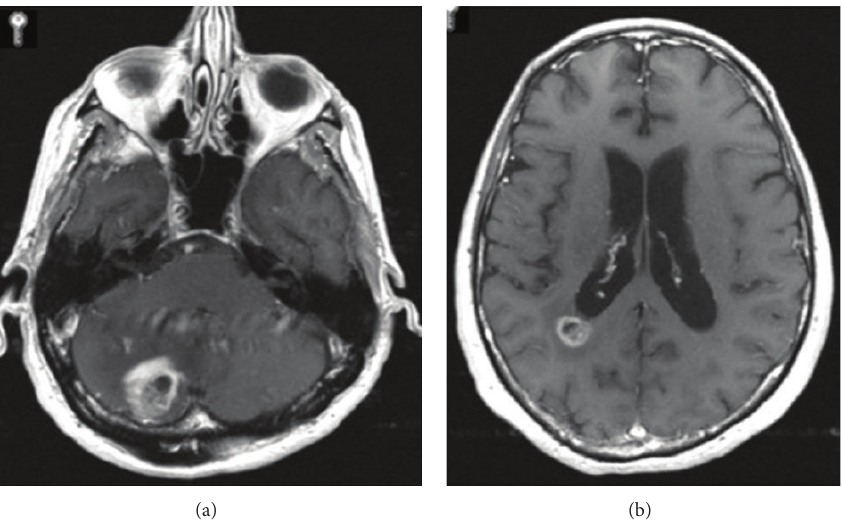
Figure 1: Preoperative MR imaging. (a) Axial T1-weighted image with contrast at the level of the cerebellum showing an enhancing mass in the right cerebellar hemisphere measuring 2.9 cm × 2.4 cm. (b) Axial T1-weighted image with contrast at the level of the lateral ventricles demonstrating an enhancing lesion in the right posterior periventricular region measuring 1.0 cm × 1.4